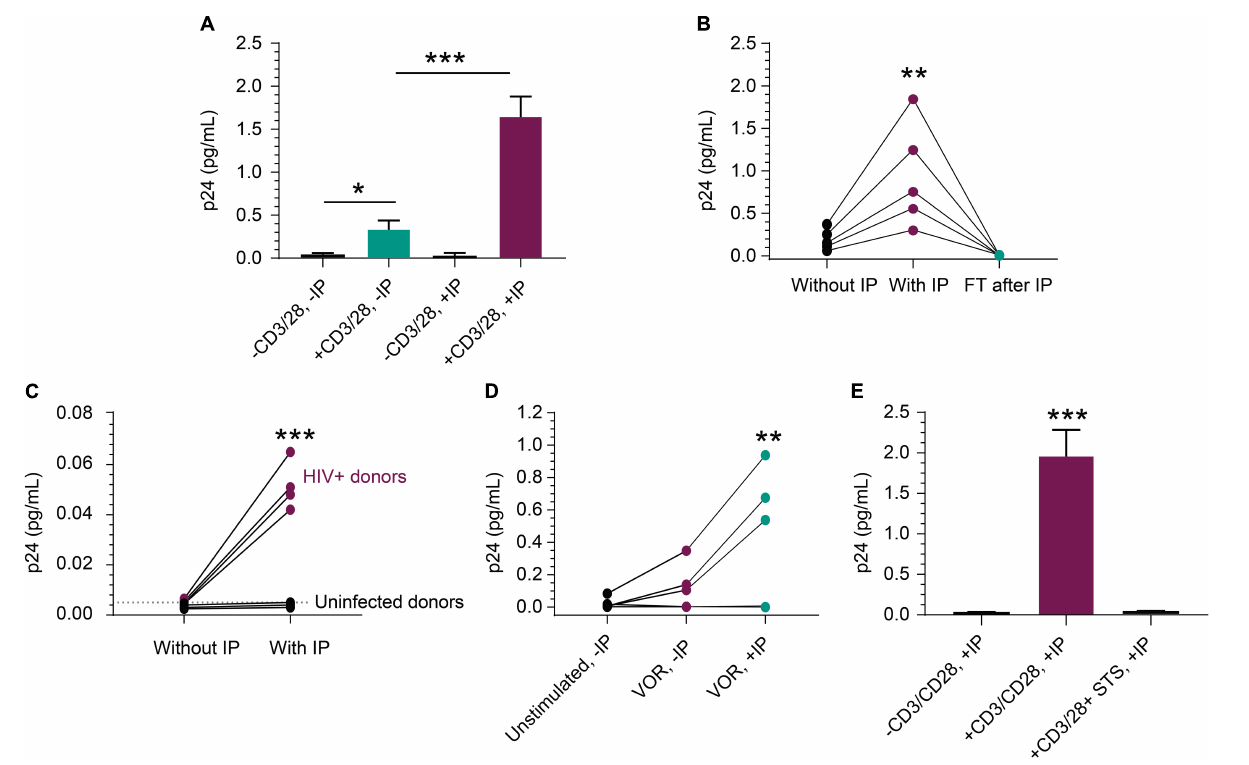
FIGURE 3 | Detection of p24 from HIV + , ART-suppressed peripheral blood CD4 + T cells. (A) p24 production was induced in CD4 + T cells following a 3-day stimulation with anti-CD3/anti-CD28 beads ( n = 3 independent experiments, p < 0.05). p24 was enriched 5-fold with a 5-fold volume reduction after IP in treated group ( n = 3, p < 0.001), but not in unstimulated group. (B) From samples that respond well to stimulus, p24 was enriched proportionally to volume reduction in five inducible donors ( p < 0.01), and no detectable p24 was observed in their flow through after IP. (C) From samples that do not show robust p24 production after stimulation, IP enrichment was able to demonstrate that p24 is indeed produced but was not at the limit of detection without enrichment. Even with enrichment and bead stimulation, p24 was not detected from HIV-negative CD4 + T cells and shows significant difference ( p < 0.001) between HIV + and uninfected donors after IP. (D) p24 protein was detected following a 3-day treatment with 1 µ M VOR in three of the five donors’ CD4 + T cells (4 × 10 6 cells/condition). The signal was enriched significantly after p24 IP with 4-fold cell lysate volume reduction ( p < 0.01). No p24 was detected from unstimulated cells. This opens the door for studying